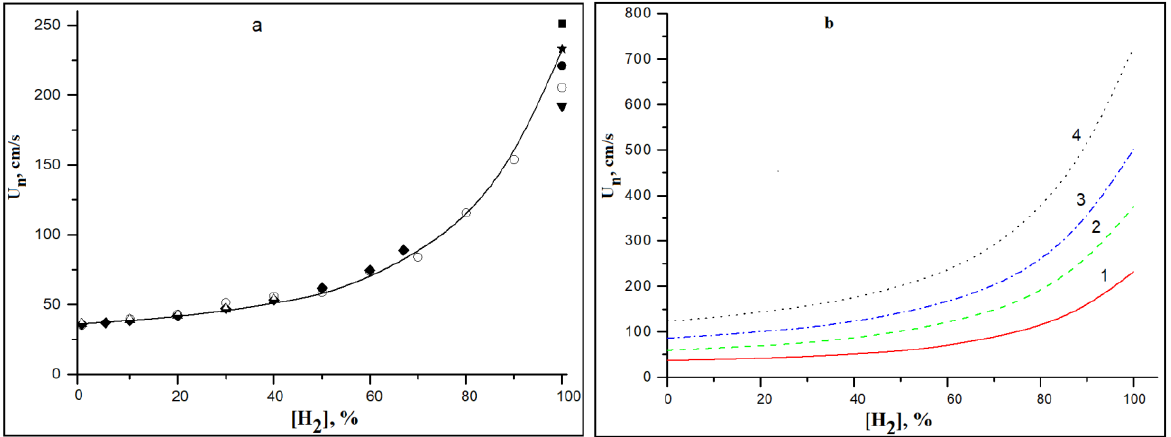
Figure 6. Dependence of laminar burning velocity U n in stoichiometric of CH 4 – H 2 -air mixtures on the concentration of hydrogen. ( a ) T 0 = 293 K (line — calculation by the mechanism [31,32], symbols — on the concentration of hydrogen. ( a ) T 0 = 293 K (line—calculation by the mechanism [31,32], experimental values from literary sources:  — [38], o — [40], ♦ —[41], ●— [42],  — [43],  — [44], symbols—experimental values from literary sources: (cid:52) —[38], o —[40], (cid:7) —[41], • —[42], (cid:72) —[43], ■ — [45]. ( b ) Calculation at T 0 (K): 1 — 300, 2 — 400, 3 — 500, 4 — 600. (cid:70) —[44], (cid:4) —[45]. ( b ) Calculation at T 0 (K): 1 —300, 2 —400, 3 —500, 4